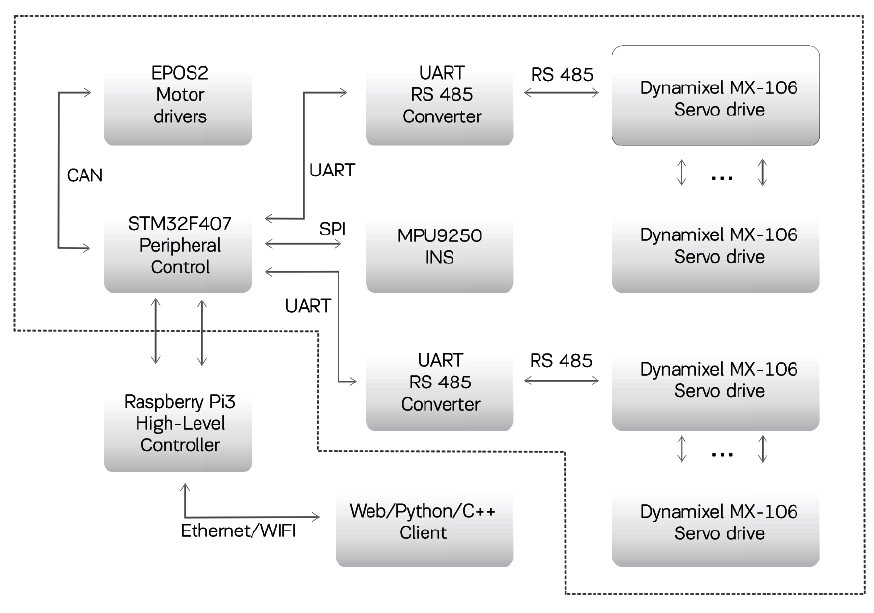
Figure 6. Implementation of the architecture of the AnyWalker control computing